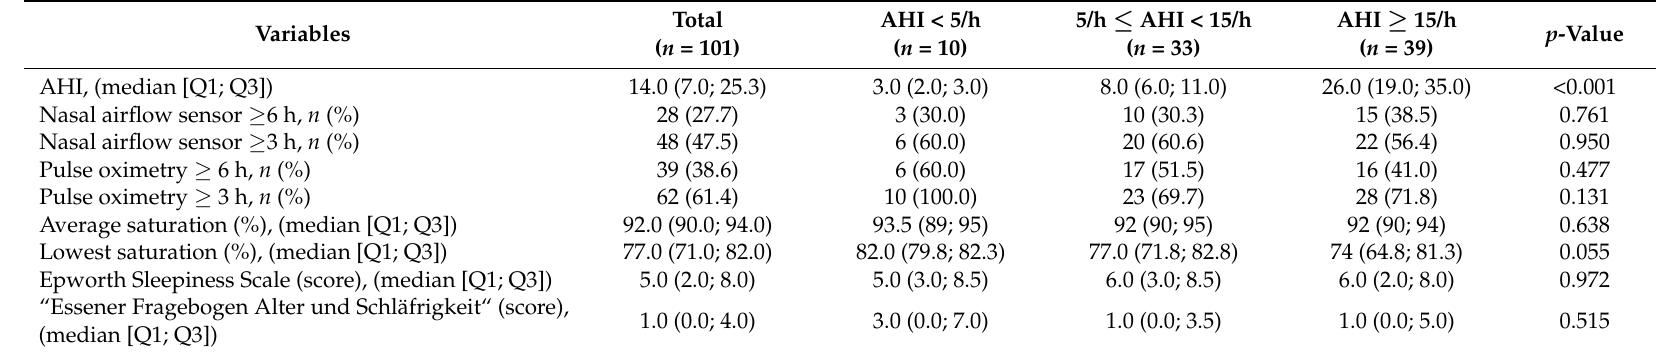
Table 2. Sleep-related characteristics of the study cohort also split by AHI category.